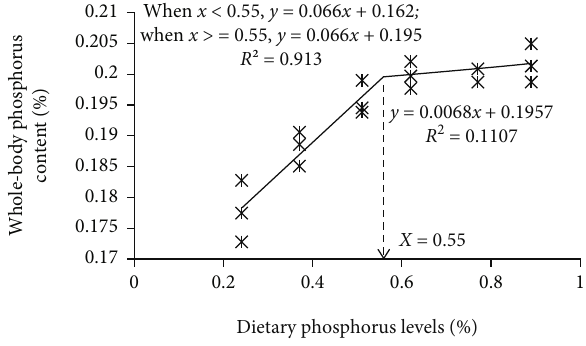
Figure 3: A piecewise regression analysis of whole-body phosphorus content ( y -axis) in sea cucumber fed diets with graded phosphorus levels ( x -axis) ( n = 3 ). The predicted dietary phosphorus level is 0.55% for the optimal whole-body phosphorus